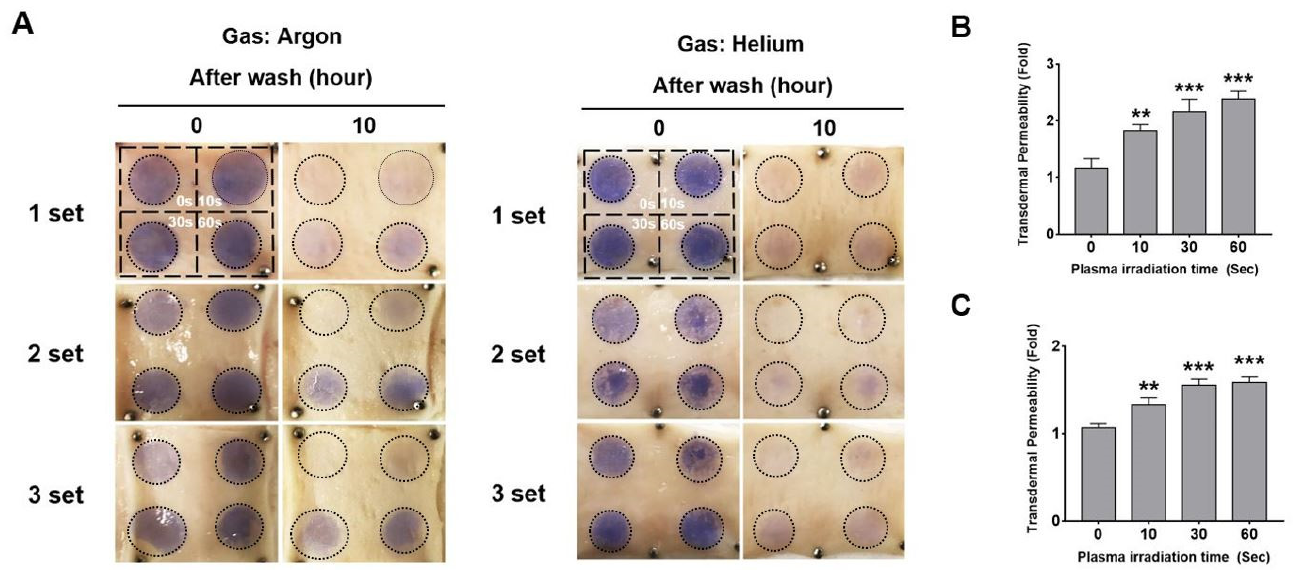
Figure 4. Transdermal absorption of aniline blue dye on porcine skin by argon and helium plasma irradiation at a distance of 4 mm ( A ) The quartered area of the rectangular area in porcine skin was treated with argon or helium plasma for 0, 10, 30, or 60 s at a distance of 4 mm between the plasma jet and the surface of the skin and thereafter stained with aniline blue dye. The transdermal permeability of aniline blue dye on porcine skin was quantified and normalized to that of the nontreated control. ( B , C ) Data are presented as means ± S.D. ** p < 0.01, *** p < 0.001 compared to the nontreated control (one-way ANOVA, Tukey’s post hoc test) with argon ( B ) or helium ( C ). n = 3 independent samples per group.